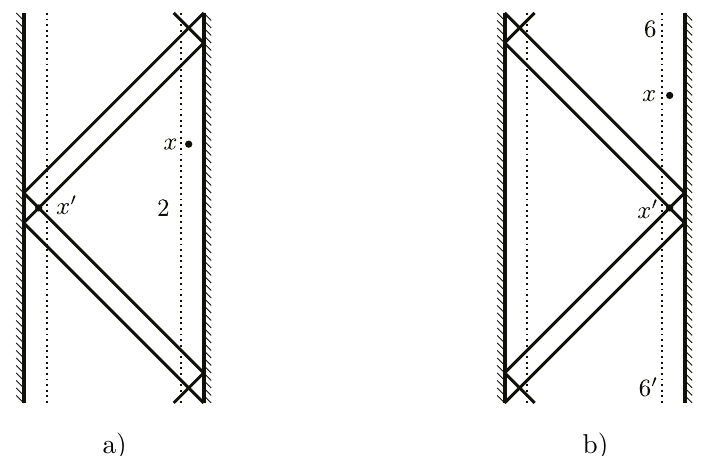
Figure 6 . Regions contributing to the asymptotic con(cid:12)guration space of a pair of points ( x; x 0 ): a) when x is restricted to a neighborhood of the right boundary and x 0 to a neighborhood of the left boundary of g AdS 2 ; b) when both points are on the